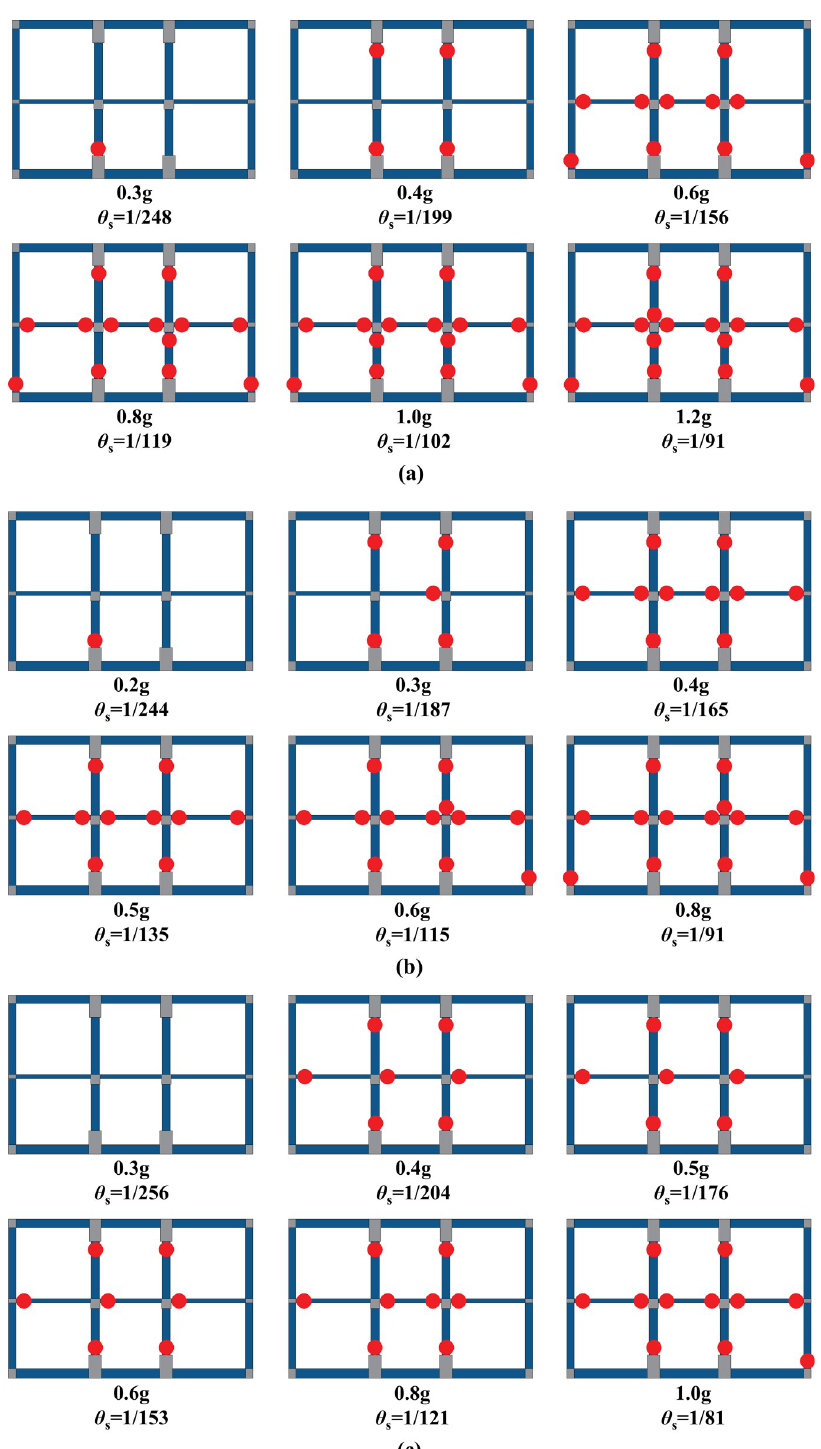
Fig 16. Plastic hinge distribution under the Northridge wave. (a) Site 1, F = 10.26, (b) Site 3, F = 4.66, (c) Site 5, F =